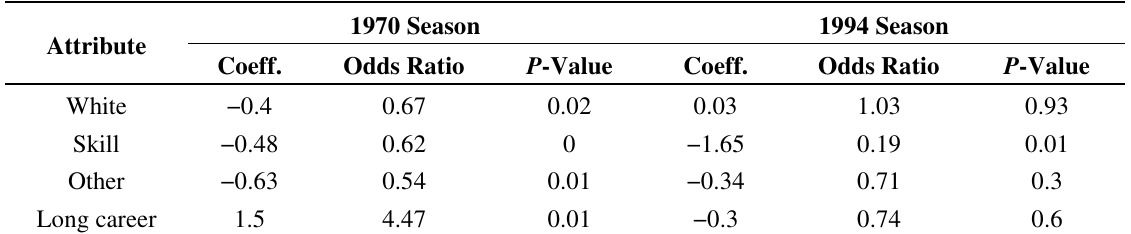
Table 4. Cox Hazard Rate Model